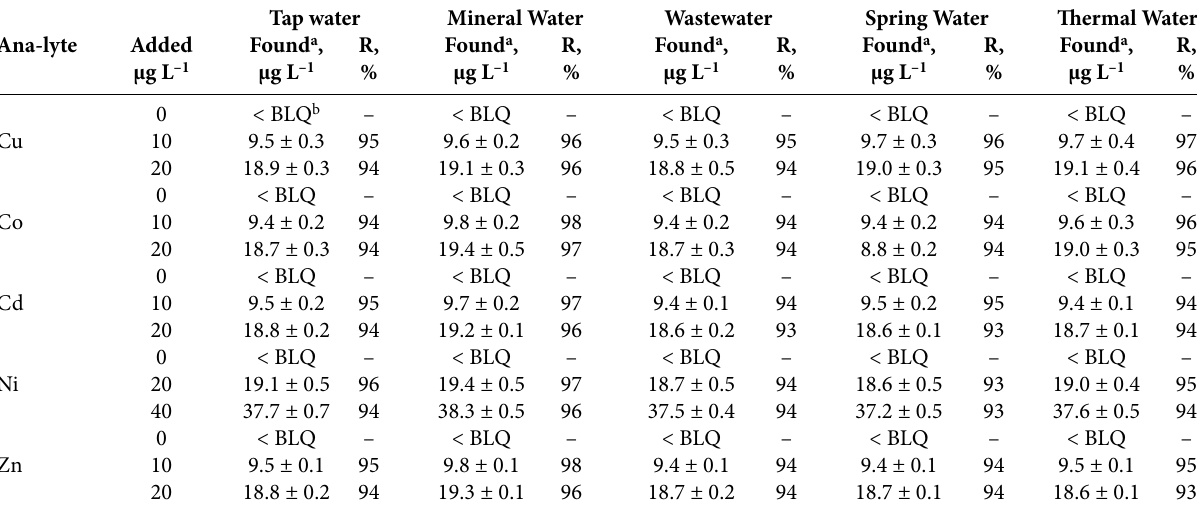
Table 6. Analysis of various water samples spiked with examined analytes (n = 3) Tap water Mineral Water Ana-lyte